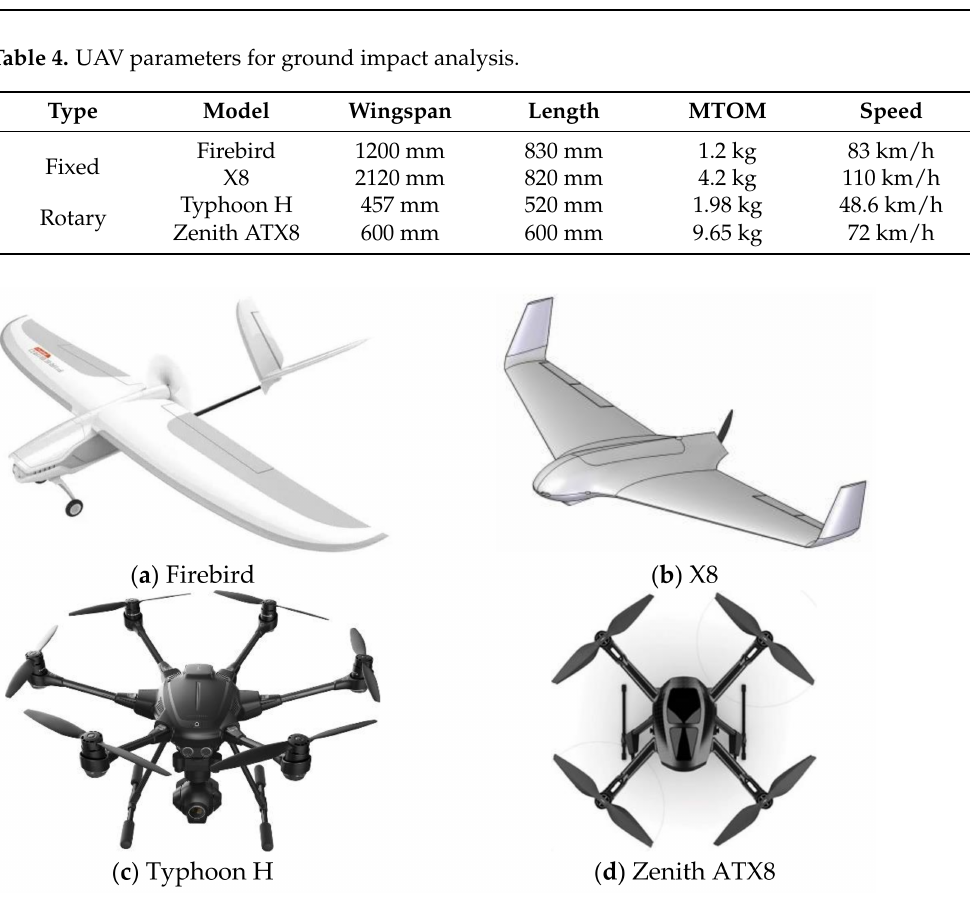
Figure 6. Images of four UAVs used in proposed